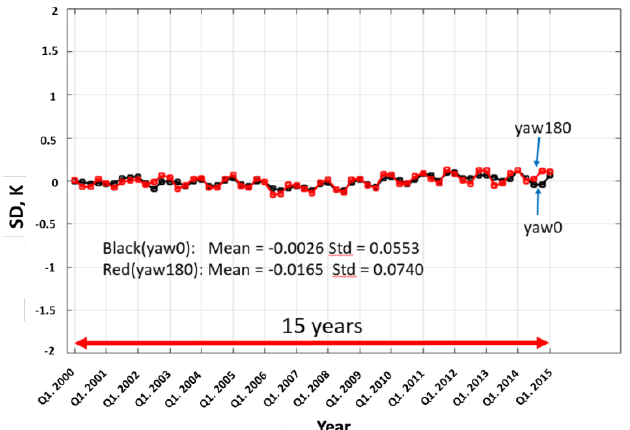
Figure 9. Single differences (SD) quarterly results for both orientations (yaw 0° in black and 180° in red) for 15 years (channel 10.65 V).